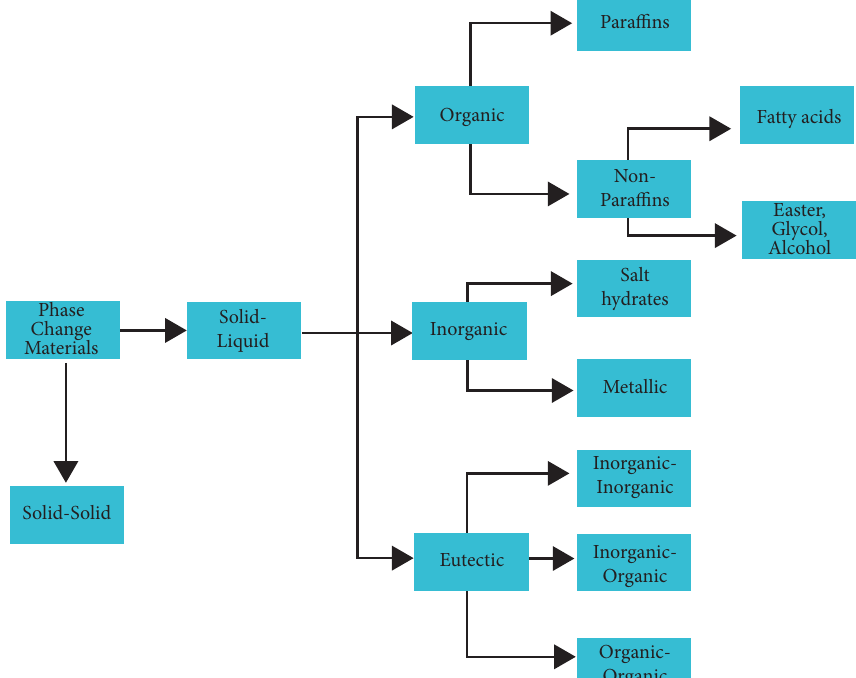
Figure 8: Categorizing phase change